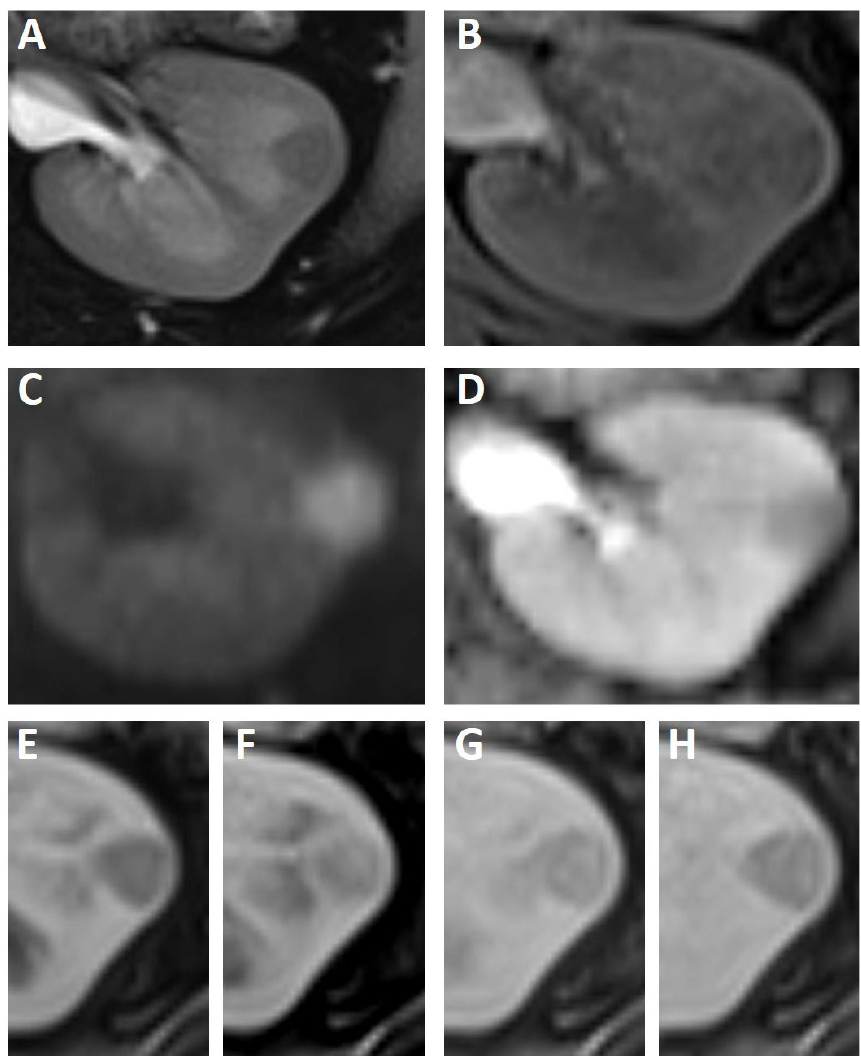
Figure 3. MRI findings of the left kidney tumor in axial planes. In this case, the bulging metanephric adenoma is with hypointense signal in T2-weighted ( A ) as well T1- weighted ( B ) images. In b800 s/mm² diffusion-weighted sequences the lesion is hyperintense ( C ) with a corresponding low signal in the apparent diffusion coefficient map ( D ). Contrast-enhanced images in arterial ( E ), portal venous ( F ), early venous ( G ) and late venous ( H ) phase demonstrate a subtle delayed enhancement of the renal mass with an indicated slight wash out in late venous phase. However, the lesion is in all imaging hypovascular compared to the renal cortex.